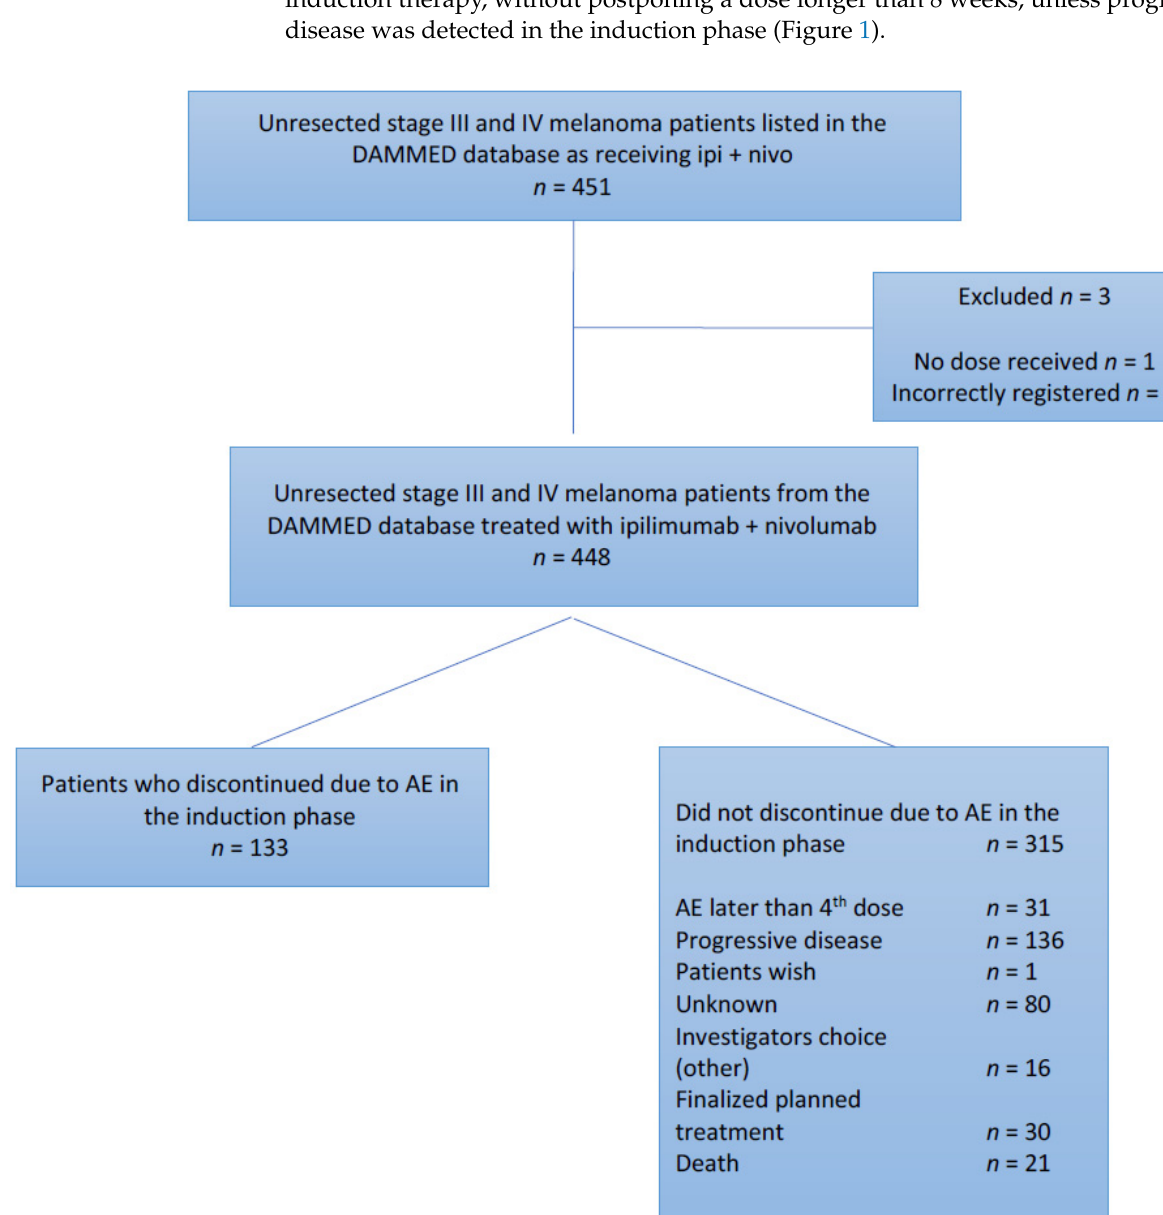
Figure 1. Patients divided into groups matching their discontinuation status and reason.